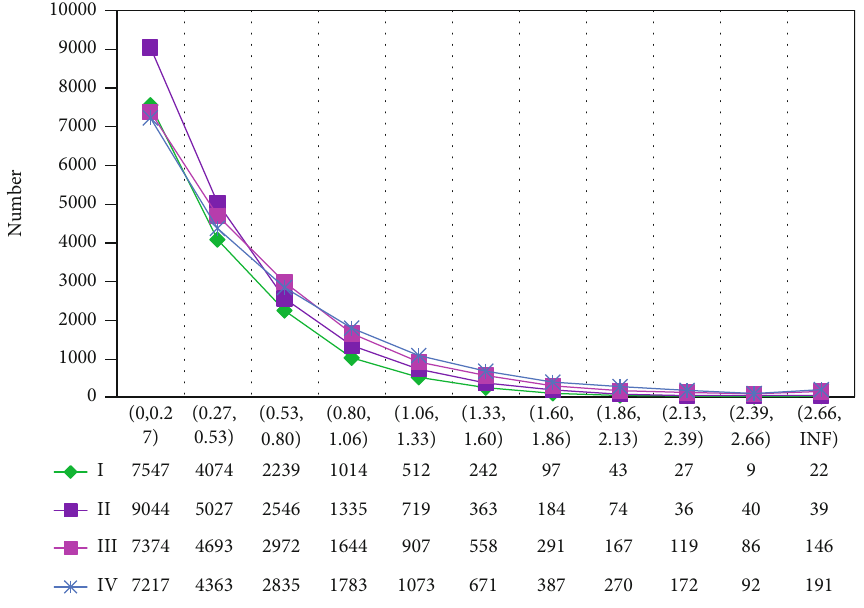
Figure 8: Distribution of perimeter variation coe ffi